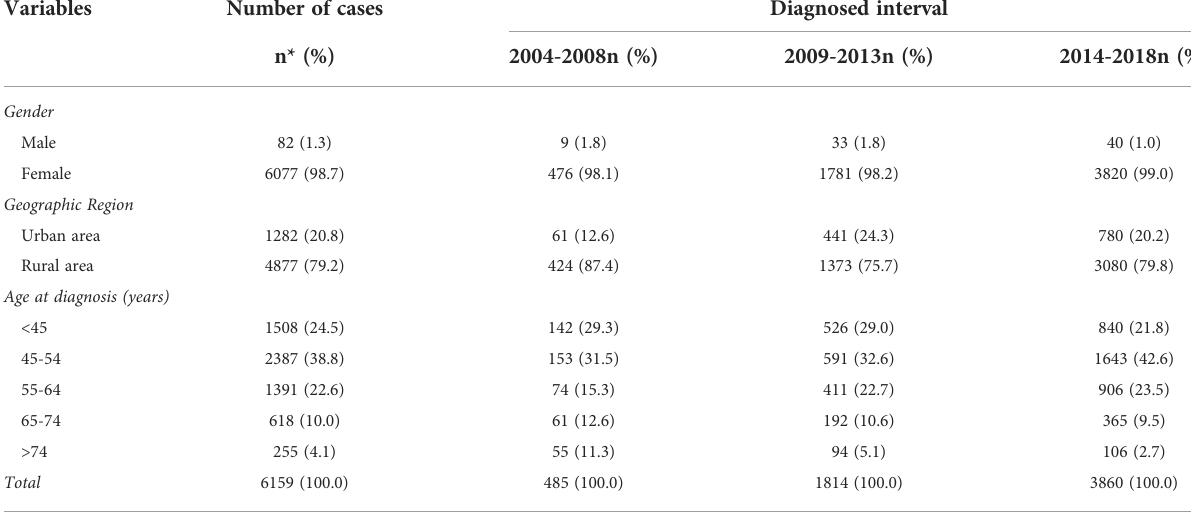
TABLE 2 Characteristics of breast cancer patients in four cancer registries of Taizhou City